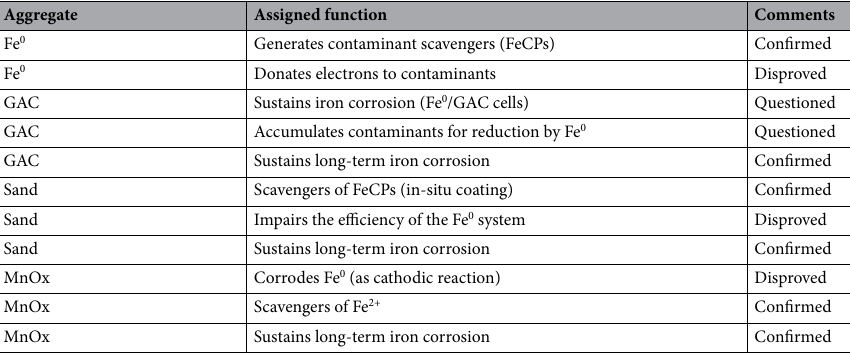
Table 1. Summary of the operating mode of some representative aggregates relevant for hybrid Fe 0 systems for water treatment. Their status according to the state-of-the-art knowledge on the Fe 0 /H 2 O system is given as comments. Questioned aspects have been documented in short-term laboratory experiments, but are not likely to be valid when the aggregates are coated with iron corrosion products